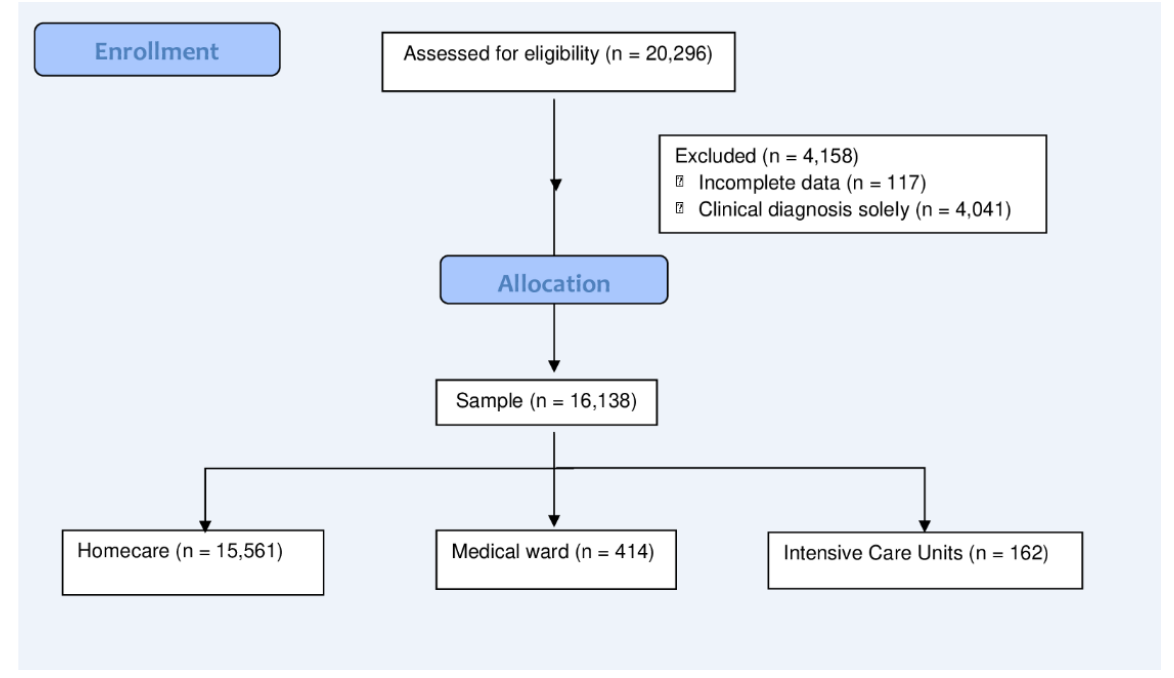
Figure 2. Flow diagram of the selection and distribution of individuals in the groups. The incidence rate of COVID-19 per 1000 inhabitants in the Xingu Health Region was 45.59 and the mortality rate was 1.01. In descending order, the highest incidence rate was observed in Vitória do Xingu (90.84), followed by Altamira (56.83), Senador José Porfírio (56.62), Brasil Novo (54.19), Medicilândia (48.07), Anapu (39.75), Pacajá (33.07), Porto de Moz (28.66), and Uruará (26.94). However, most cases were reported in Altamira (41%), Pacajá (9.9%), and Medicilândia (9.5%). It was observed that 359 individuals did not sur- vive being infected with COVID-19. In descending order, Altamira (1.62) showed the highest mortality rate, followed by Brasil Novo (1.47), Vitória do Xingu (1.44), Senador José Porfírio (1.31), Anapú (0.87), Porto de Moz (0.67), Medicilândia (0.63), Uruará (0.42), and Pacajá (0.41). Deaths were concentrated in Altamira (52%), Porto de Moz (7.8%), and Anapú (7%) (Figure 3).